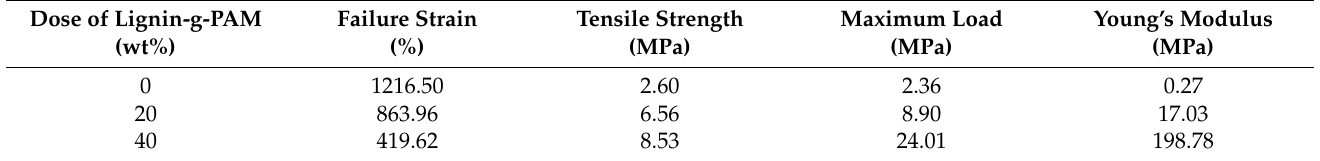
Table 3. Tensile properties of pure acrylic copolymer and lignin-grafted hybrid acrylic resins. Dose of Lignin-g-PAM